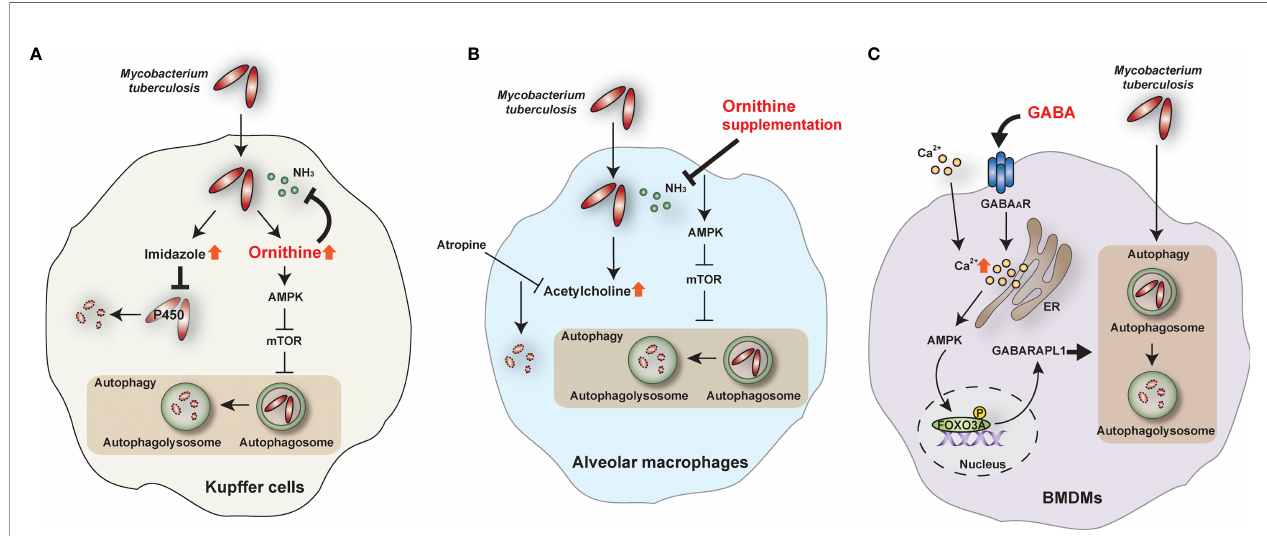
FIGURE 2 | The role of ornithine and GABA during Mtb infection. (A) In Kupffer cells, ornithine and imidazole are top-scoring metabolites during Mtb infection. Ornithine restricts Mtb growth by activating the AMPK-mediated autophagy pathway and inhibiting ammonia (NH 3 ). On the other hand, imidazole kills Mtb directly by inhibiting cytochrome P450 monooxygenases. (B) In alveolar macrophages, ornithine supplementation inhibits NH 3 and activates autophagy to restrict Mtb growth. In addition, acetylcholine is increased in Mtb-infected alveolar macrophages, and atropine, an acetylcholine antagonist, inhibits Mtb survival. (C) GABA induces intracellular calcium (Ca 2+ ) in fl ux and activates the autophagy pathway through the AMPK-GABARAPL1 pathway. Autophagy can restrict the intracellular survival of Mtb in bone marrow-derived macrophages (BMDMs). AMPK, AMP-activated protein kinase; FOXO3A, forkhead box O3A; GABA A R, GABA A receptor; GABARAPL1, GABA type A receptor-associated protein-like 1; mTOR, mammalian target of